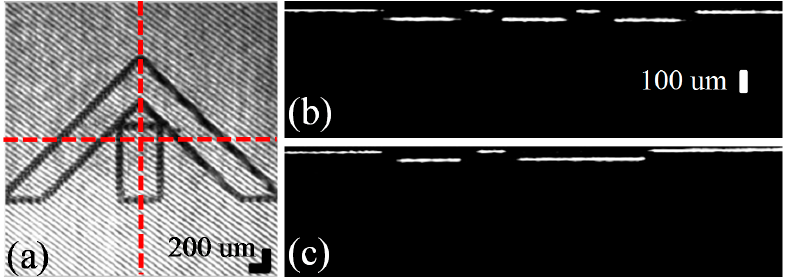
Figure 6. Tomographic images of the full-field OCT system; ( a ) Raw enface image of the VLSI 50 µm step height standard target; ( b , c ) Cross-sectional profiles along the horizontal and vertical red-colored dashed lines in ( a ), respectively.